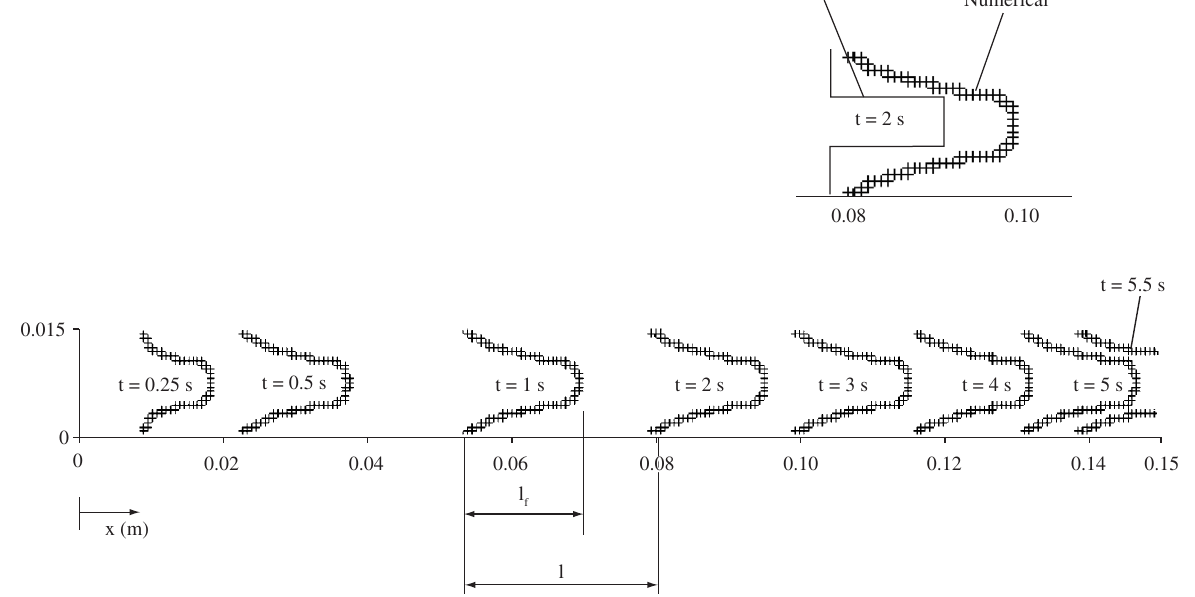
Figure 10. Resin flow-front position with time and zoom at 2 seconds (top-right).